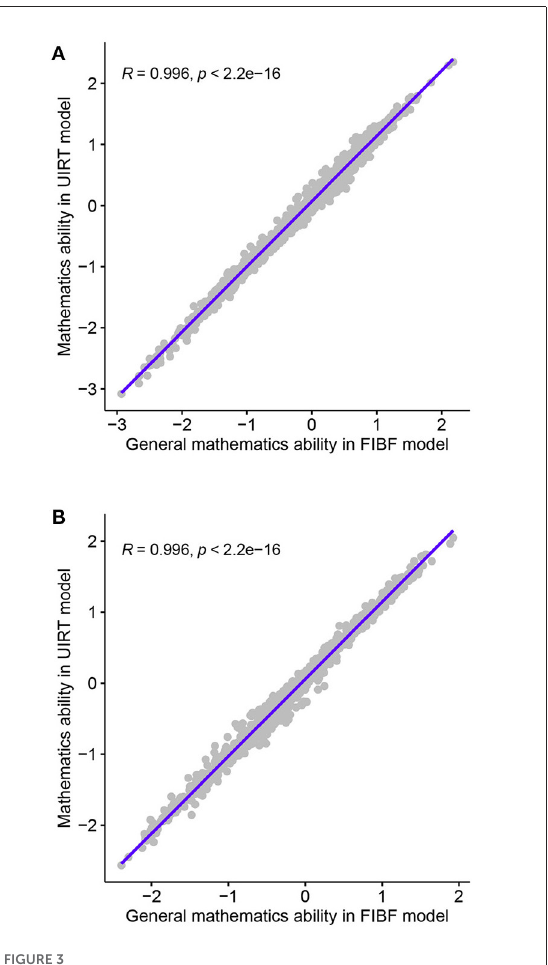
FIGURE3 Correlation coefficients between the general abilities of the FIBF model and the abilities of the UIRT model for students in the fourth and the eighth grades. (A) Fourth grade. (B) Eighth